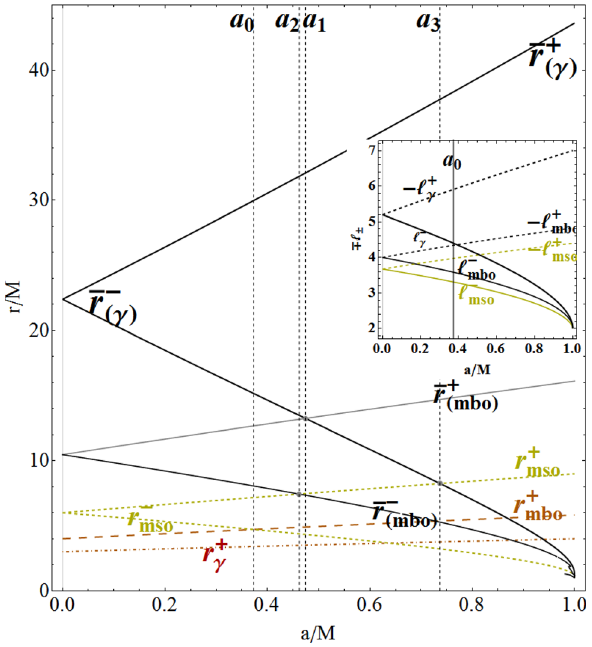
, ¯ r ± } versus a / M ∈ [ 0 , 1 ] . Spins Fig. 3 Radii {¯ r ± (γ) , ¯ r ± ( ( mso ) mbo ) { a , a , a } , introduced in Eq. (11), and a 1 2 3 0 introduced in Sect. 4.2 are also shown. The marginally stable circular orbit r ± mso , the marginally bounded circular orbit r ± and finally the marginal (photon) circu- mbo lar orbit r + γ , for counterrotating ( + ) and corotating ( − ) fluids are also ,(cid:4) ± } shown. Inside panel : fluid specific angular momentum { (cid:4) ± γ ,(cid:4) ± mso mbo as function of the dimensionless spin a / M ∈ [ 0 , 1